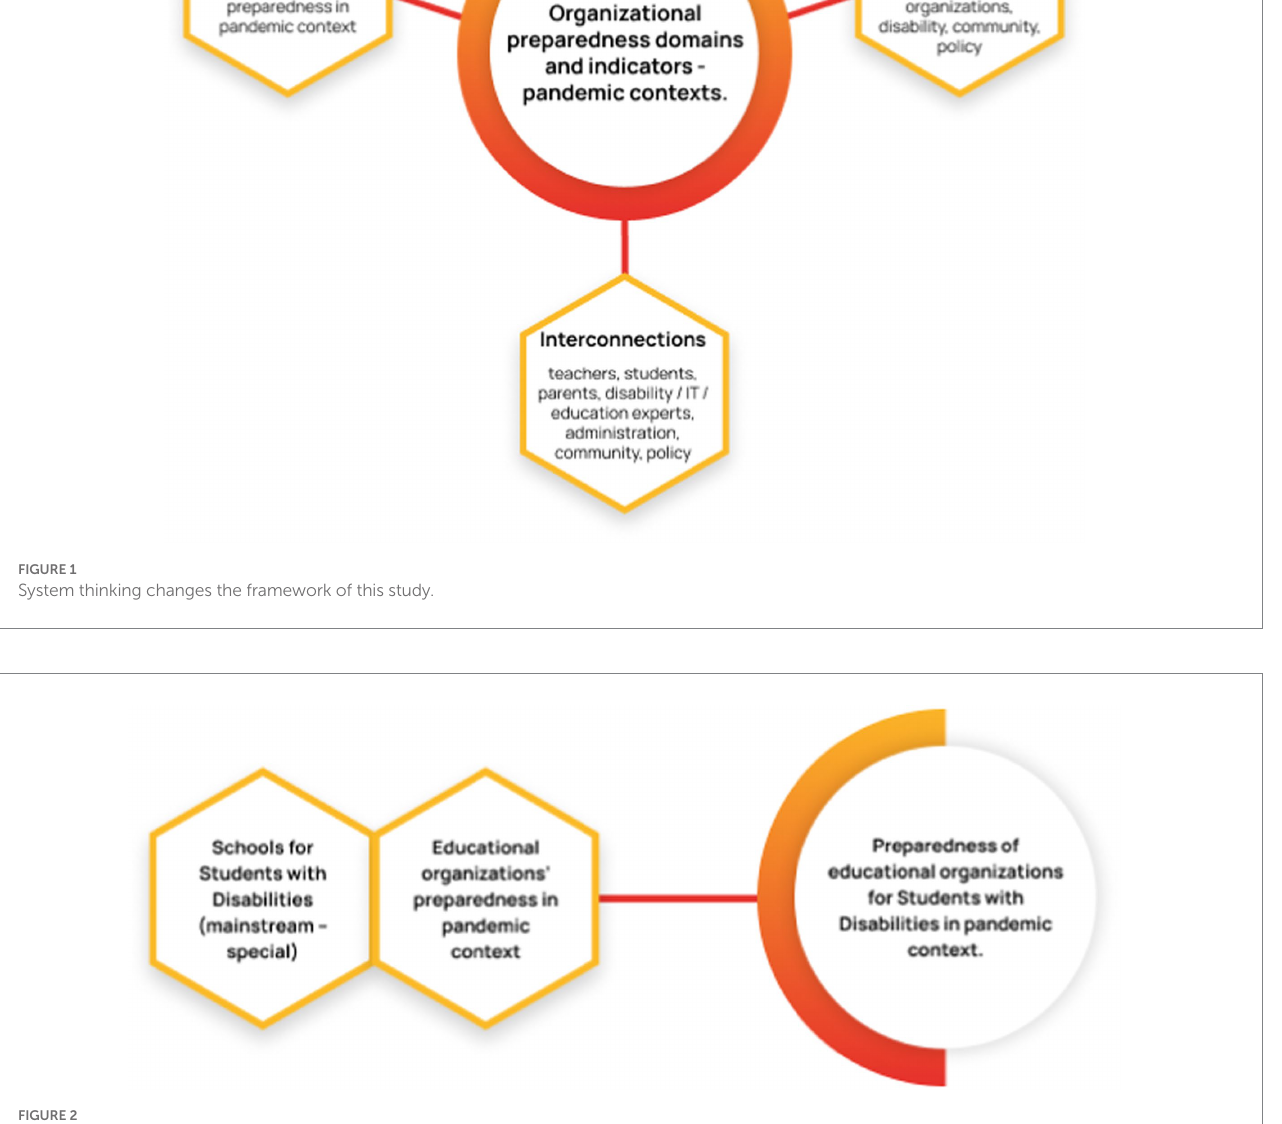
FIGURE 2 Research focus of this